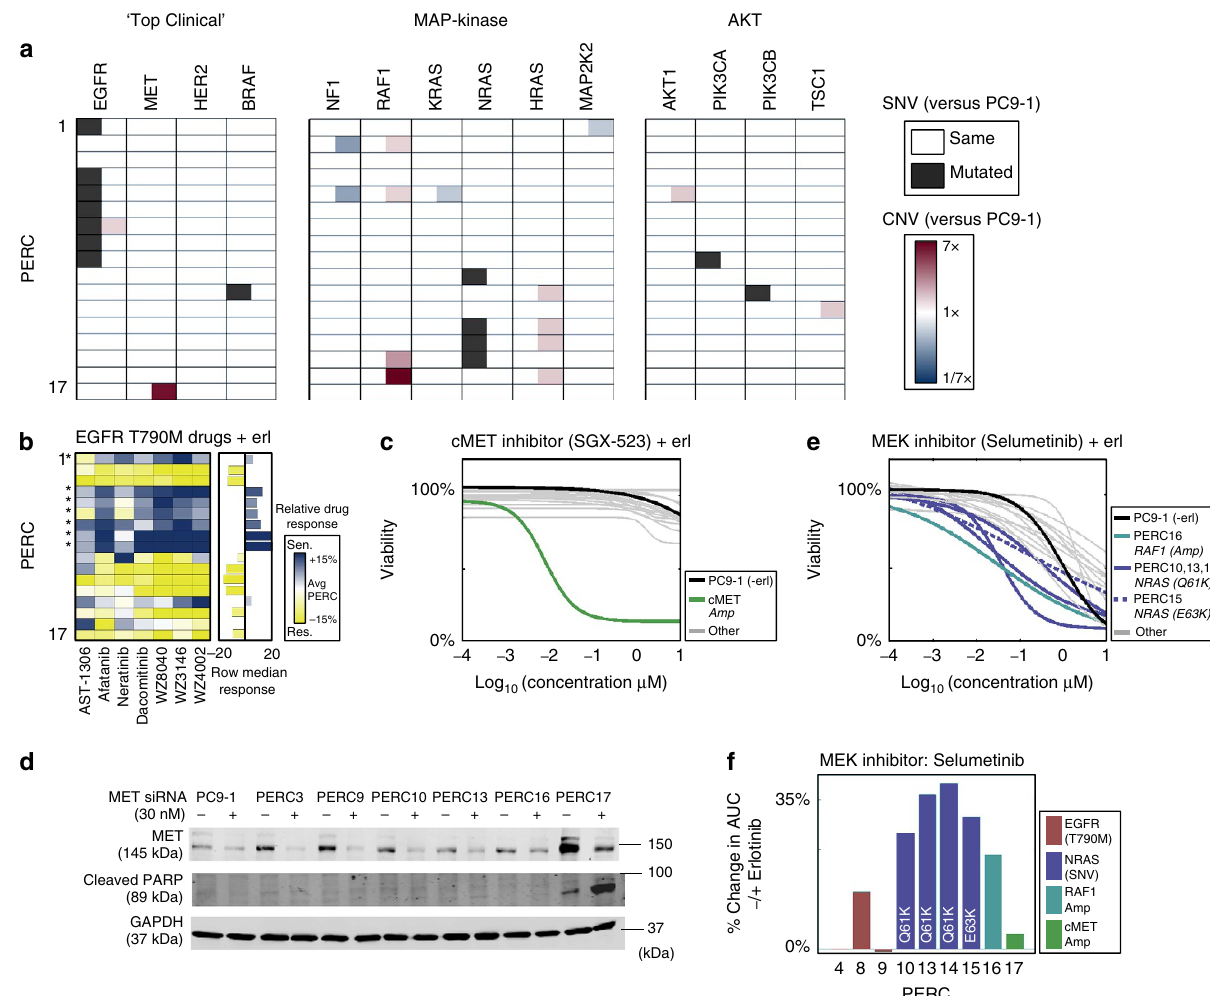
Figure 3 | Assessment of PERC drug-resistance mechanisms via genetics and specific perturbations. ( a ) Comparison of genetic alterations in PERCs (rows) for selected genes implicated in erlotinib resistance (columns). Black: presence of a non-synonymous single-nucleotide variant (SNV) versus PC9-1; red/blue: CNVs corresponding to amplification/deletions of genetic regions (Methods) versus PC9-1. ( b – f ) Corroboration of genetic information with predicted vulnerabilities. (PERCs were in erlotinib media; PC9-1 cells were in erlotinib-free media). ( b ) Response among PERCs to drugs targeting the EGFR T790M mutation: (left) heatmap: relative response of PERCs (rows) to EGFR T790M drugs (columns). Drug response (blue/yellow) is assessed by change in the AUC of a PERC from the mean AUC among all PERCs (Methods). (Right) Bar plot: row median response across drugs. *: PERCs with EGFR T790M mutation. ( c ) PERC dose–response curves to SGX-523, targeting cMET. Colours: PC9-1 (black); cMET-amplified PERC17 (green); other PERCs